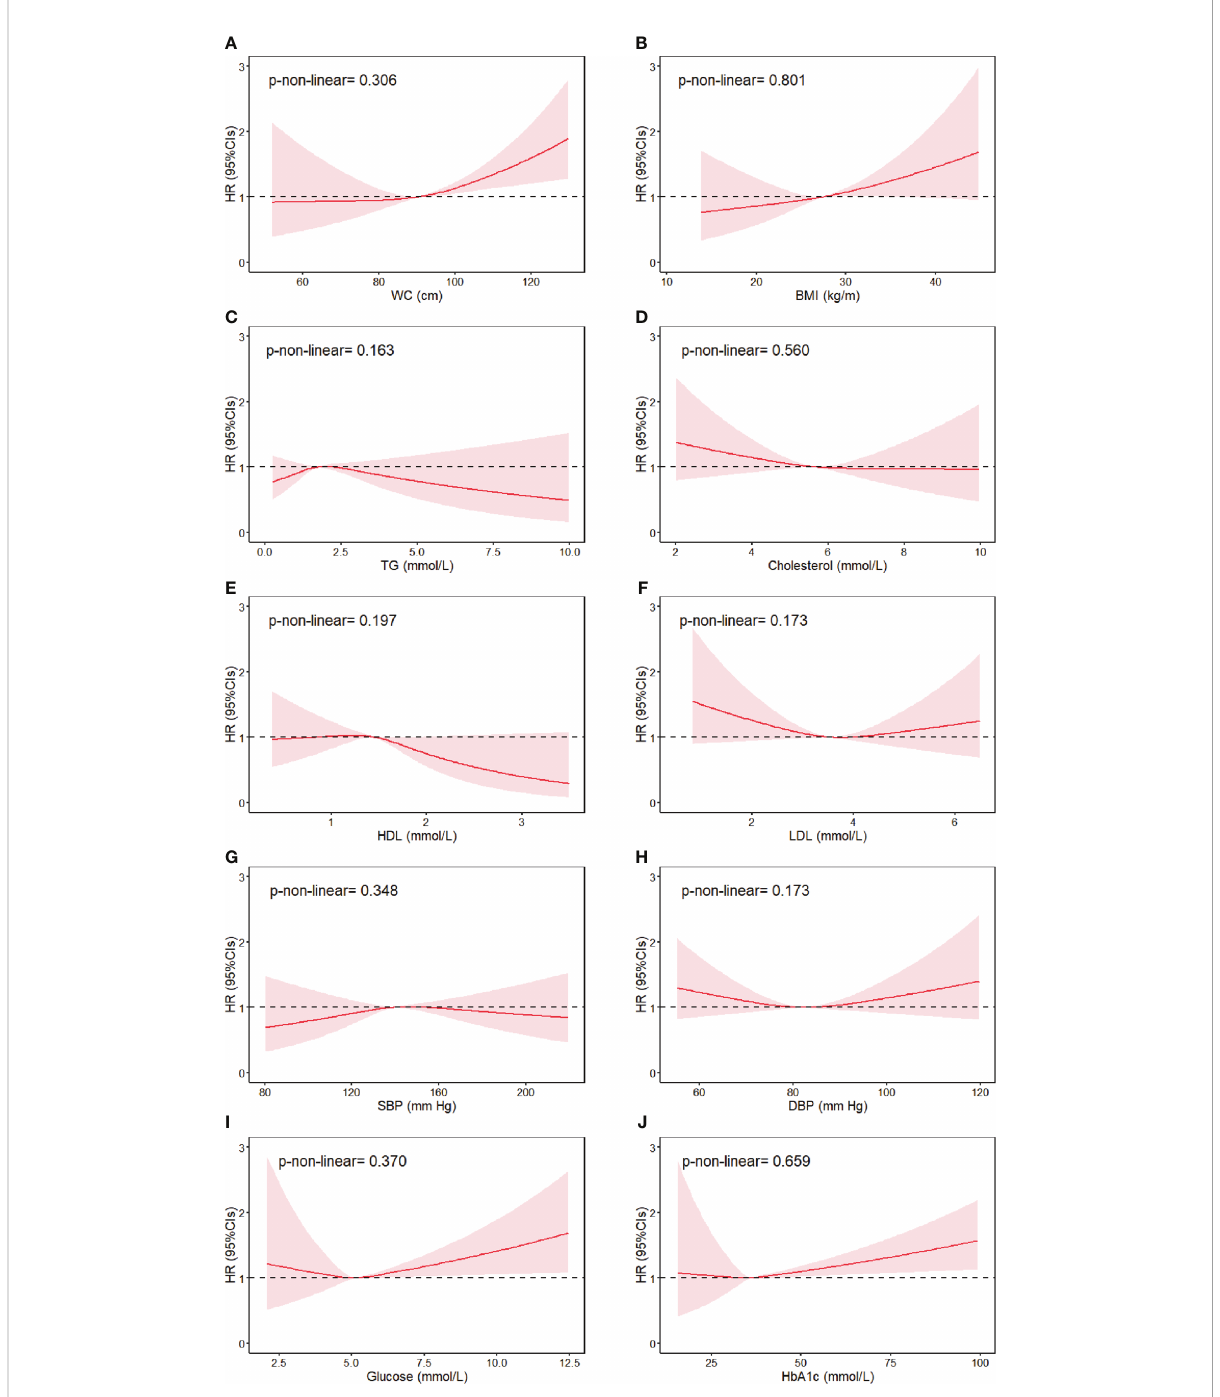
FIGURE 1 Association between individual MetS components and risk of bladder cancer, allowing for non-linear effects. (A) WC, (B) BMI, (C) TG, (D) Cholesterol, (E) HDL, (F) LDL, (G) SBP, (H) DBP, (I) Glucose, (J) HbA1c. The reference levels of MetS components in these plots (with HR fi xed as 1.0) were 90.27 cm for WC, 27.42 kg/m 2 for BMI, 1.74 mmol/L for triglyceride, 5.69 mmol/L for cholesterol, 1.45 mmol/L for HDL-cholesterol, 3.56 mmol/L for LDL-cholesterol, 139.6 mm Hg for SBP and 82.25 mm Hg for DBP, 5.12 mmol/L for fasting glucose, and 36.08 mmol/L for HbA1c. Separate models were fi tted using restricted cubic spline with three knots at 10th, 50th, and 90th percentiles for each MetS component, adjusted for age at baseline, gender, UK Biobank assessment center, race, education, index of multiple deprivation, smoking status, alcohol consumption, physical activity, portions of fruit and vegetable intake, regular medications (multivitamin use, mineral supplement, non-steroidal anti-in fl ammatory drugs, and aspirin), and general health indicator variables (overall health rating and long-standing